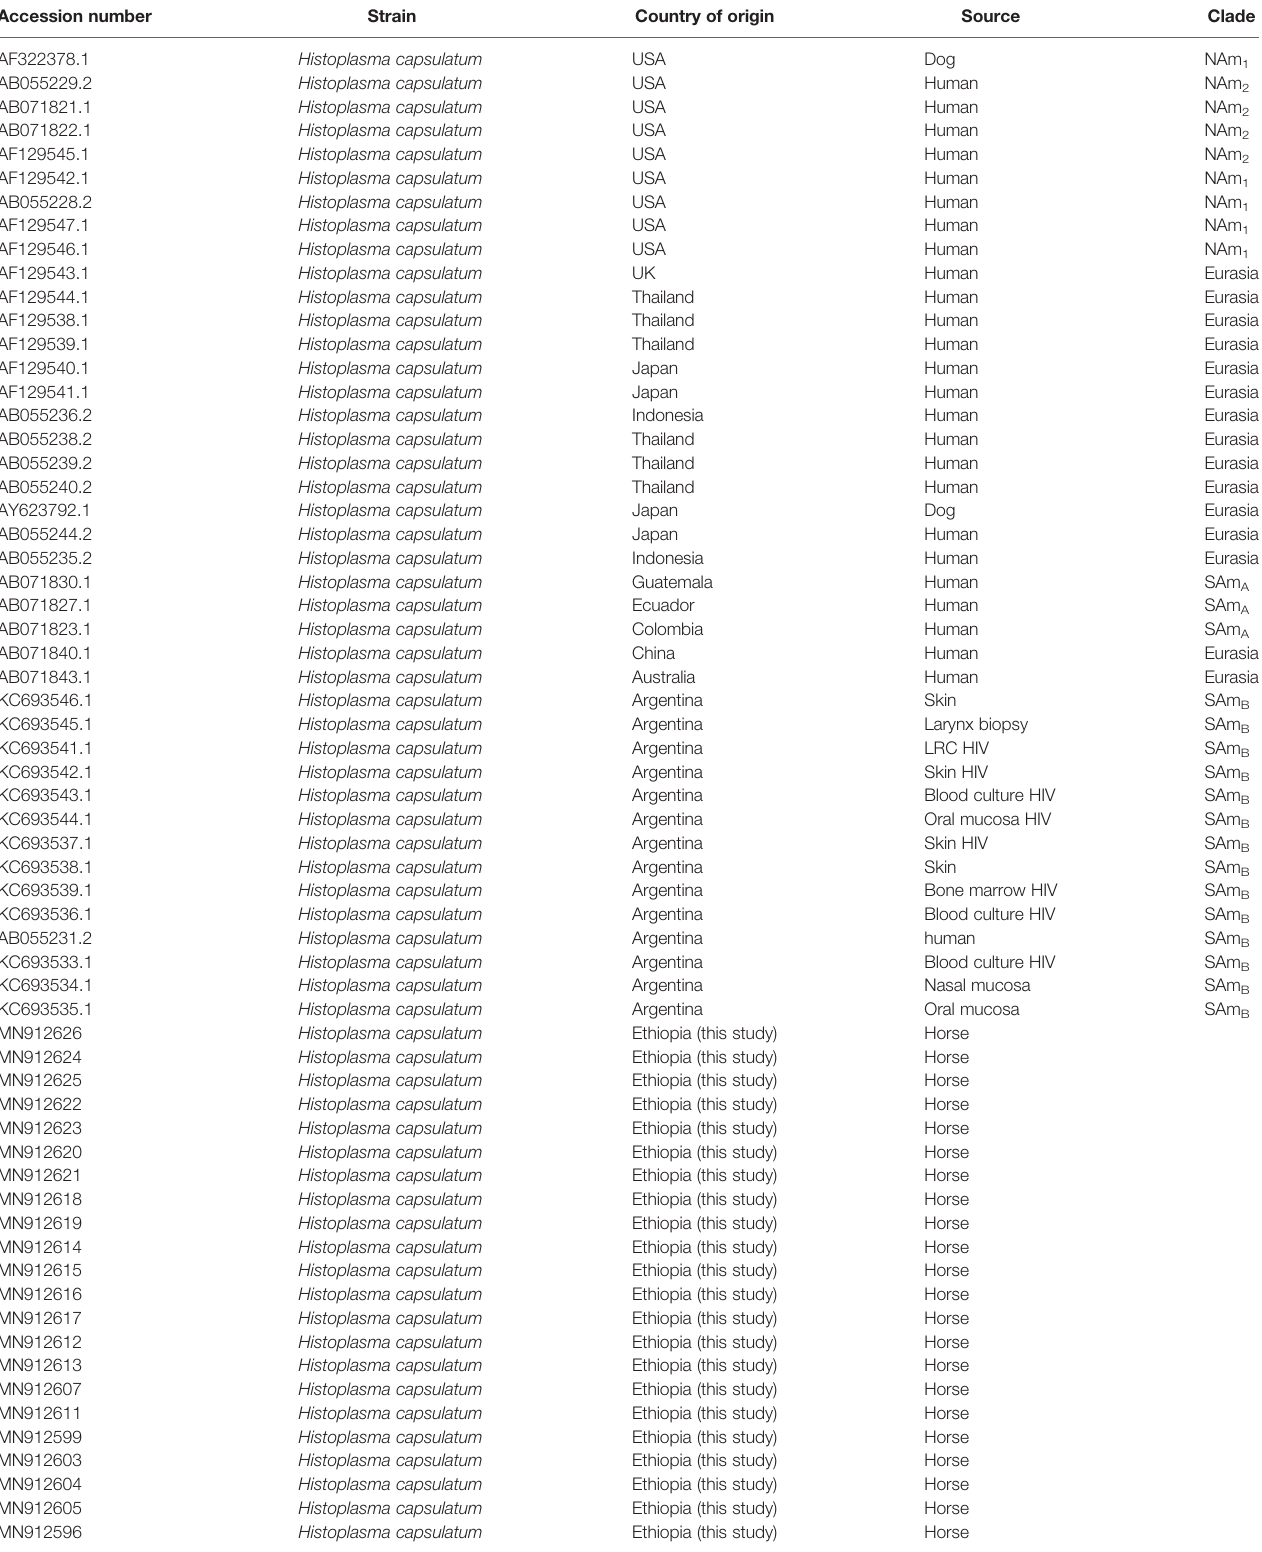
TABLE 2 | Accession numbers of the H. capsulatum isolates included in the phylogenetic analysis and their countries of origin. Accession